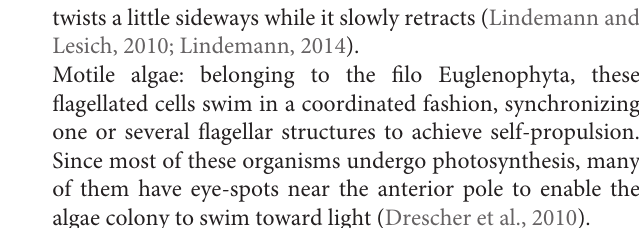
FIGURE 1 | Schematic representation of natural and biohybrid swimmers on different length scales, showing how the characteristic swimmer velocity and Reynolds number changes with length scale. The classification of Bacterial biohybrid microswimmers according to the bacteria: object ratio is indicated; see the main text for